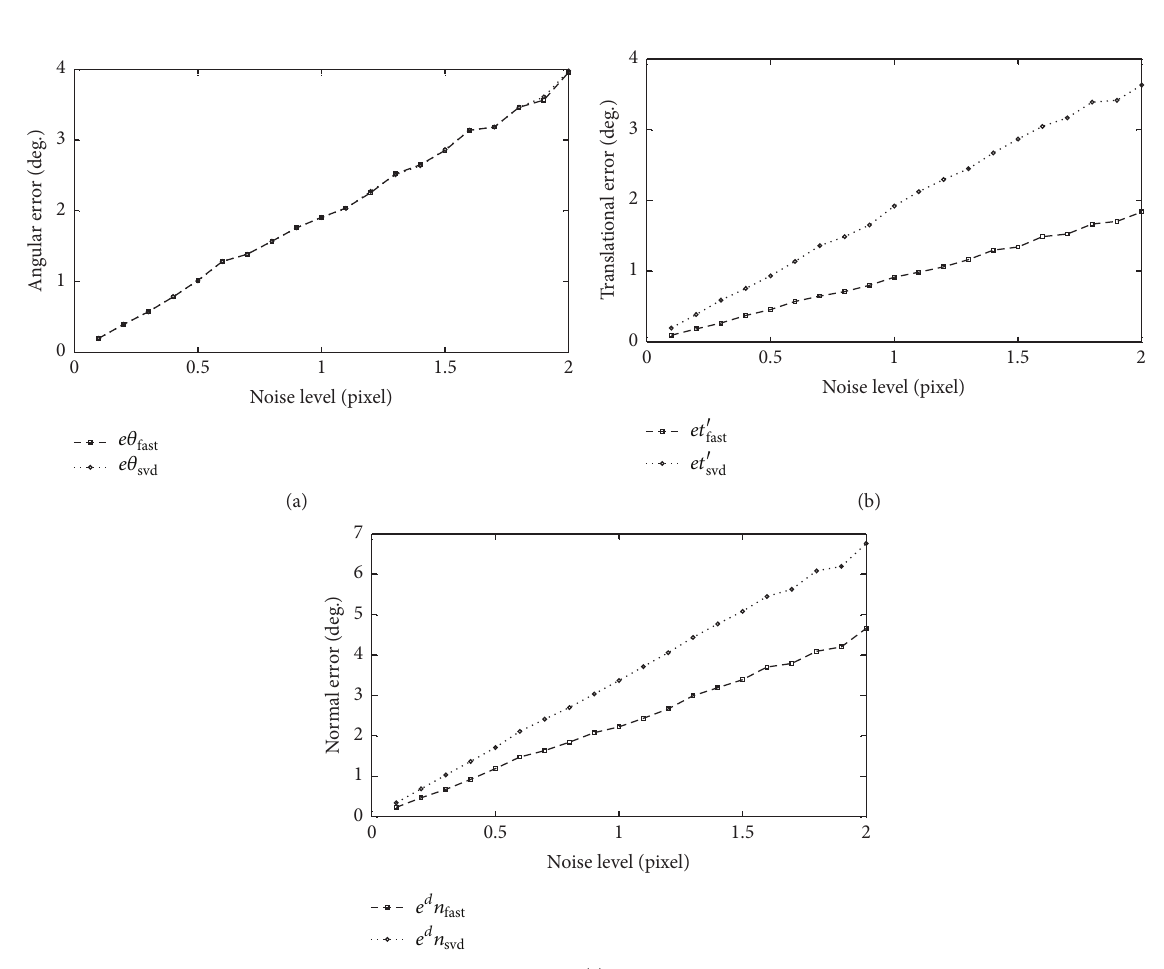
Figure 5: Comparison of the traditional algorithm and the proposed algorithm with regard to different pixel noise